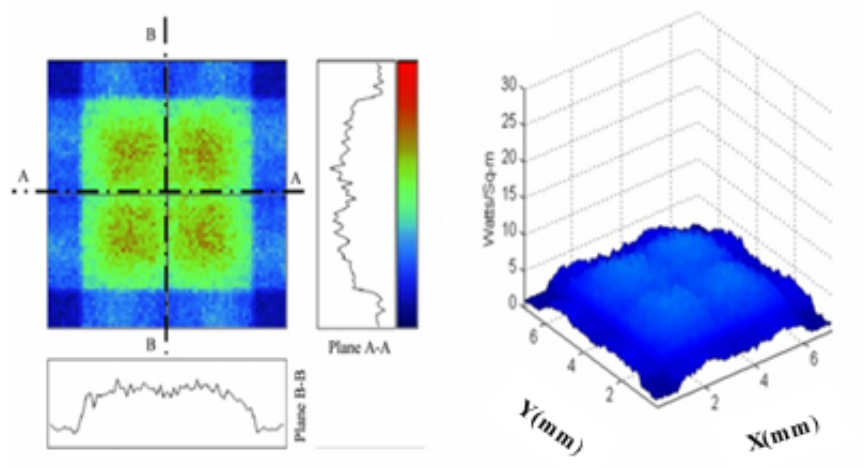
Figure 40. Flux distribution at the exit of the CPV system proposed by Lokeswaran et al. [73]. Reprinted from S. Lokeswaran et al., Design and analysis of dense array CPV receiver for square parabolic dish system with CPC array as secondary concentrator, Solar Energy 2020, 199, 782–795, with permission from